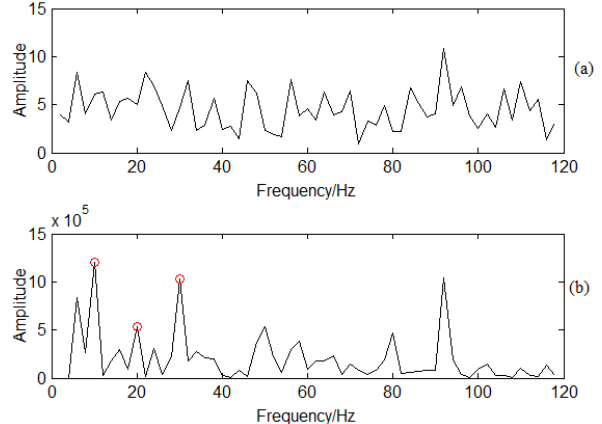
Figure 6. Demodulation analysis for the simulation signal: ( a ) Envelope spectrum analysis; ( b ) SES